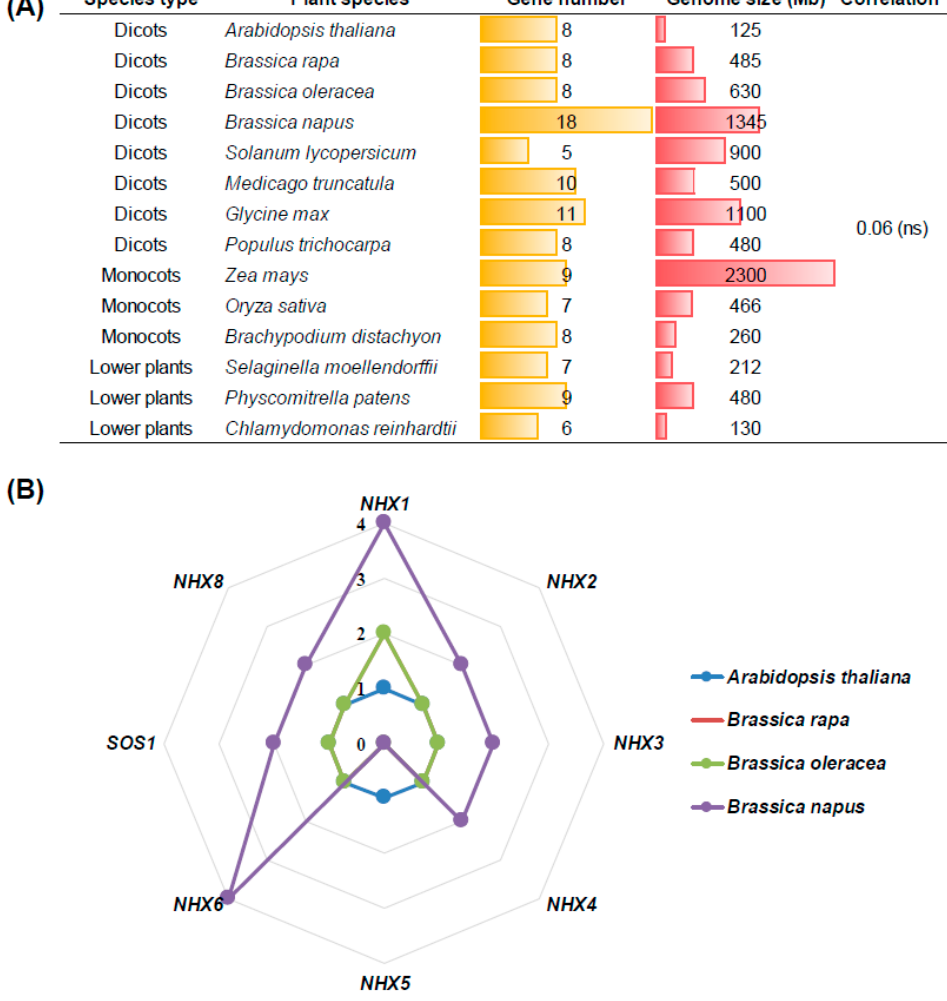
Figure 1. Copy number of the Na +/ H + antiporter ( NHX ) family members in plant species. ( A ) Comparison of the total gene number of the NHX family in plant species. The correlation refers to the relationship between the NHX family gene numbers and plant genome sizes. ns: not significant. ( B ) Each NHX subgroup member number in Arabidopsis and three Brassica crops ( Brassica rapa , Brassica oleracea , and Brassica napus ). Table 1. Copy number of the Na + / H + antiporter ( NHX ) genes in Arabidopsis and Brassica